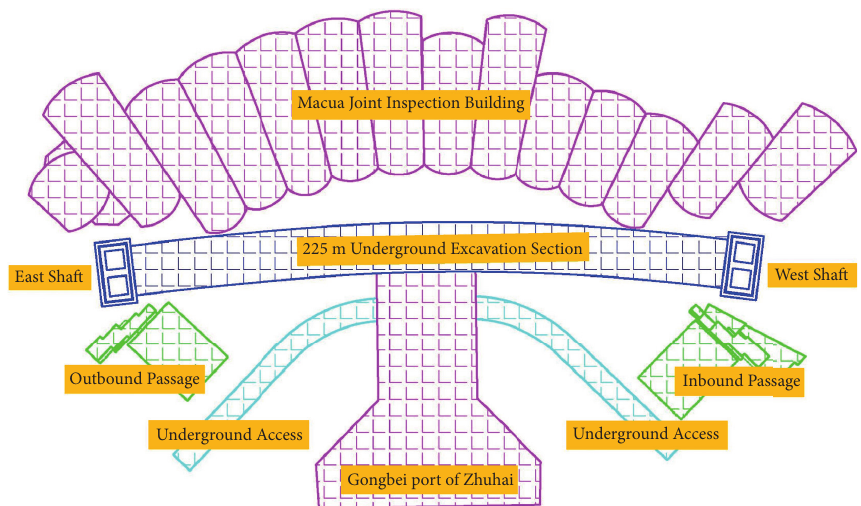
Figure 1: Layout chart of the Gongbei undercut tunnel.